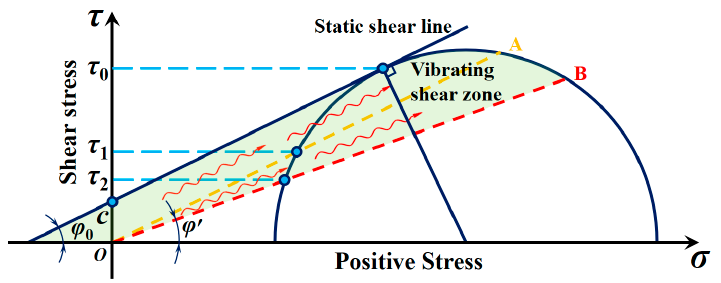
Figure 5. The relationship between Mohr–Coulomb failure criterion and soil vibration shear state.